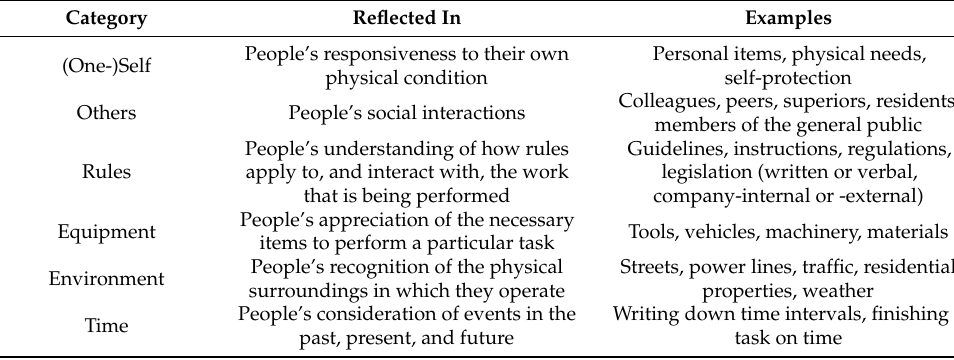
Table 3. Categories of heedfulness with